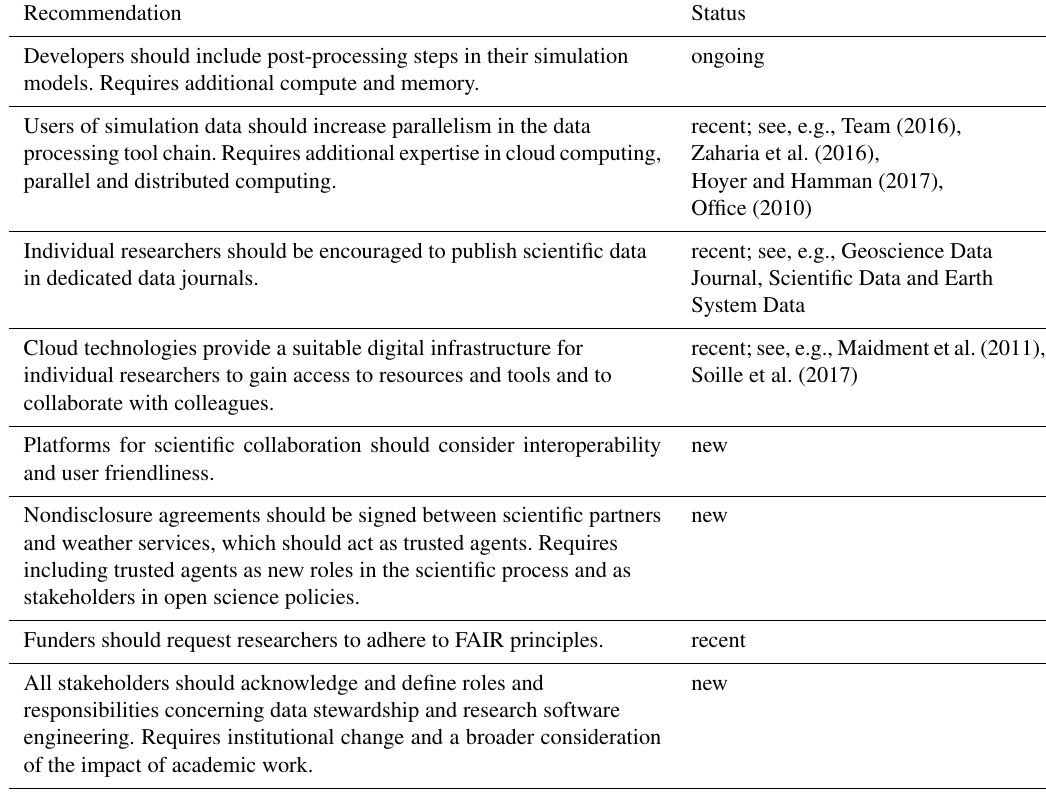
Table 1. Concrete recommendations which will bring us closer to open weather and climate science.